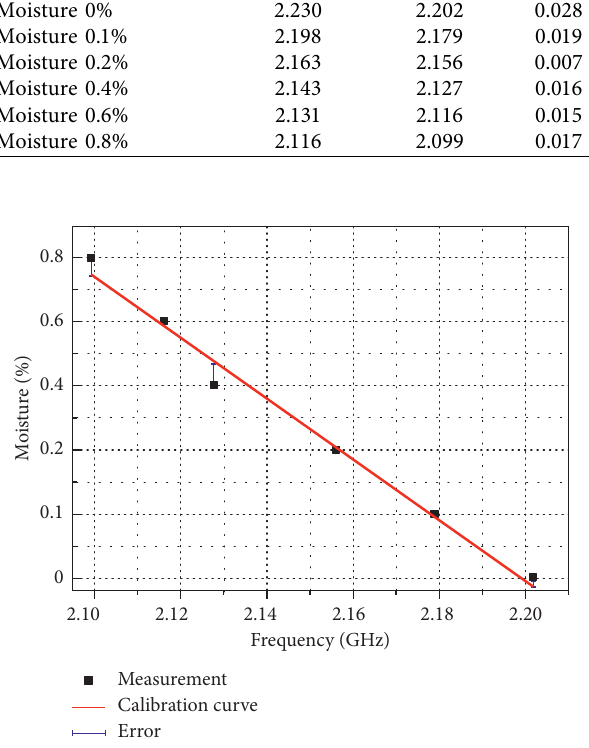
Figure 11: Relationship between moisture content of lubricating oil in microfluidic channel and antenna operating frequency.